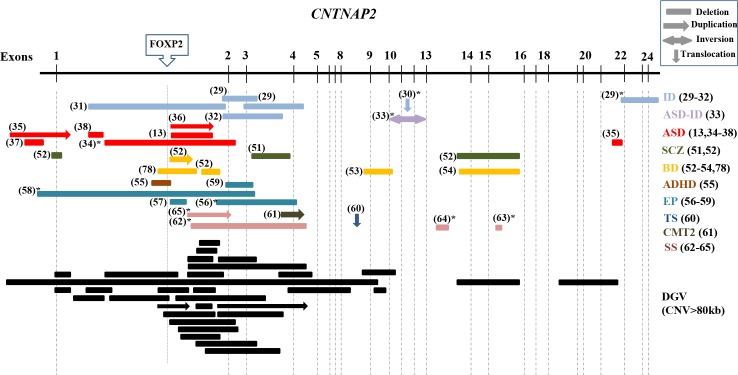
Overview of heterozygous CNVs spanning the CNTNAP2 gene across several diseases.Abbreviations: ID (Intellectual disability), ASD (autism spectrum disorder), SCZ (schizophrenia), BD (bipolar disorder), ADHD (Attention-deficit/hyperactivity disorder), EP (epilepsy), TS (Tourette syndrome), CMT2 (axonal Charcot-Marie-Tooth), and SS (Speech spectrum: speech delay, childhood apraxia of speech and dyslexia). In parenthesis is reported the reference to each study. *, additional rearrangements reported in this patient. The dashed lines represent the exons and the upper box shows the position of the FOXP2 binding site. In dark shading, CNVs≥80kb found in the general populations from the Database of Genomic Variants are shown.